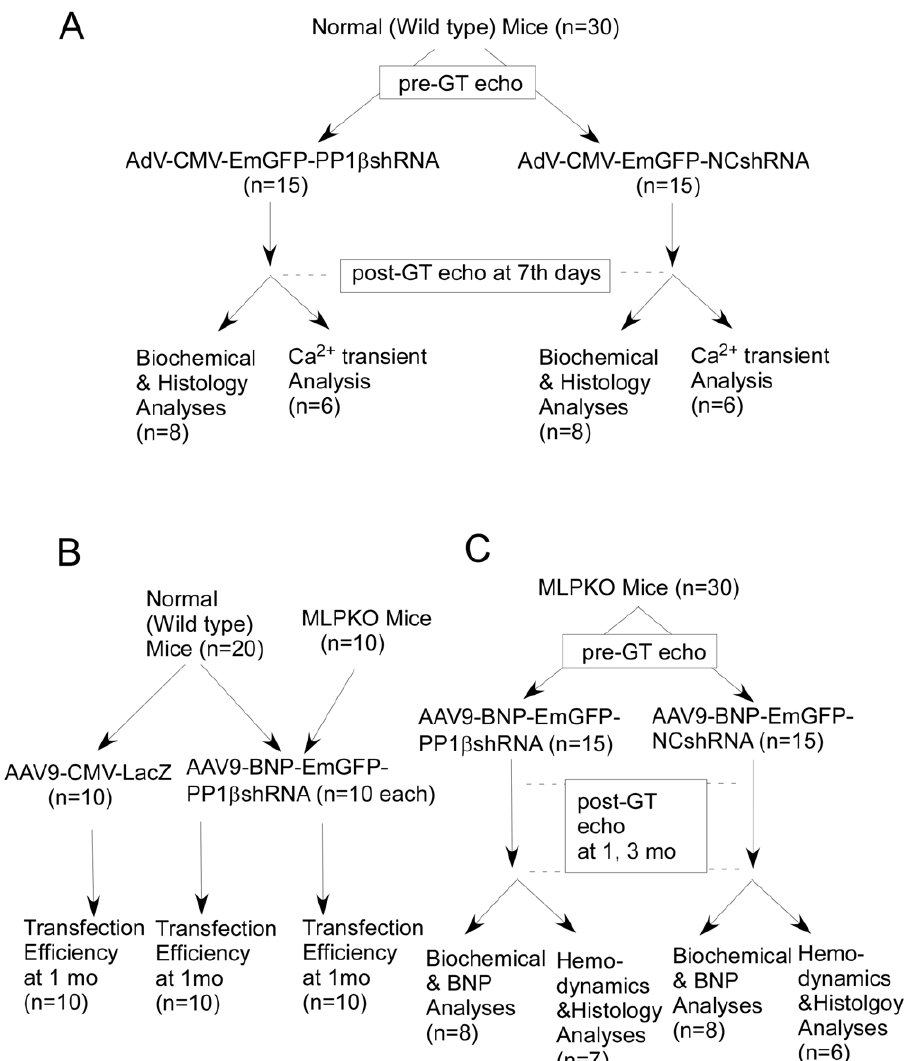
Figure 1. Experimental designs. A : The experiment confirming the effect of in vivo RNA polymerase II promoter-mediated shRNA in normal mice using AdV vectors. B : The experiment confirming AAV9-BNP promoter-mediated gene transfer transfection efficiency at 1 month after gene transfer in normal and MLPKO mice. C : The experiment assessing the effects of in vivo AAV9-BNP promoter-mediated heart-failure condition-specific shRNA in MLPKO mice